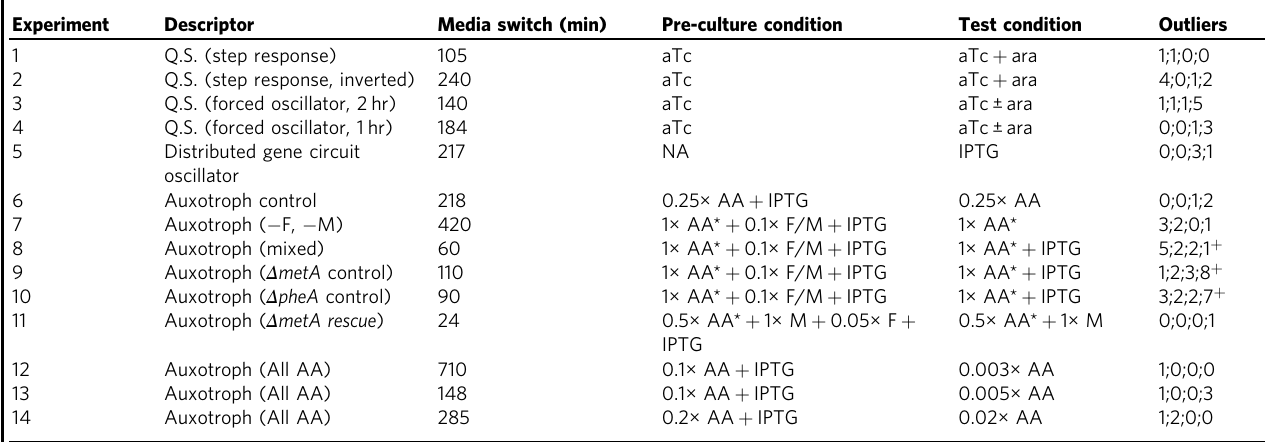
Pre-culture conditions refer to the environment within the micro fl uidic device from the beginning of the experiment to the time of the fi rst media switch. Test culture conditions refer to the media conditions following the fi rst media switch. Quorum-sensing experiments were performed in Luria Broth (LB), whereas remaining experiments used MOPS EZ Rich De fi ned Medium, with the modi fi cations speci fi ed above. AA refers to EZ amino acid solutions containing all amino acids and AA* refers to an amino acid solution lacking methionine (M) or phenylalanine (F). In experiments where F and M were added separately, 1× F and M refers to 0.4mM and 0.2mM, respectively. The pre-culture amino acid fraction was varied to control cell growth and fl uorescent reporter expression. Outliers refer to the number of paired growth chambers that were excluded from the analysis out of n = 10 biologicalreplicates for each interaction channel length (25 μ m;50 μ m;100 μ m;250 μ m) based on a set of speci fi c criteria (Methods). + For these experiments, the numbers represent single outlier growth chambers that were excluded from the analysis out of n = 20 total biological replicates